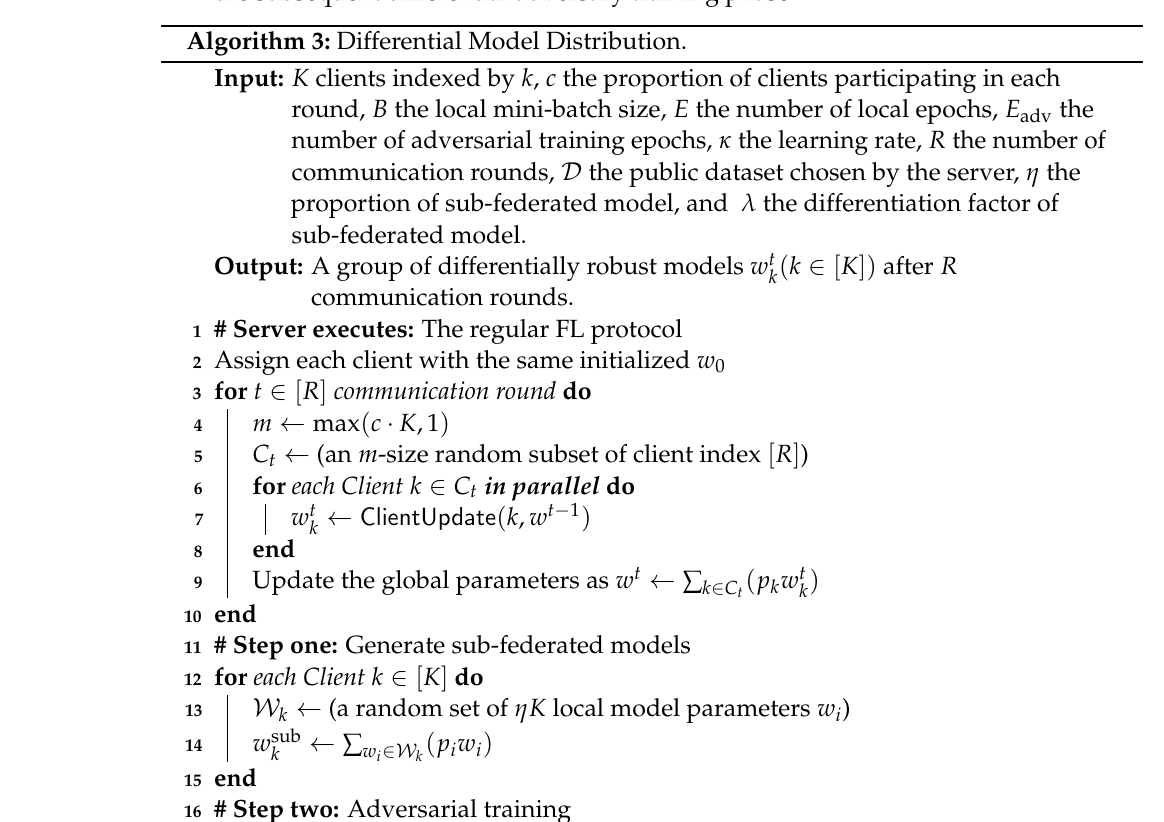
Algorithm 3: Differential Model